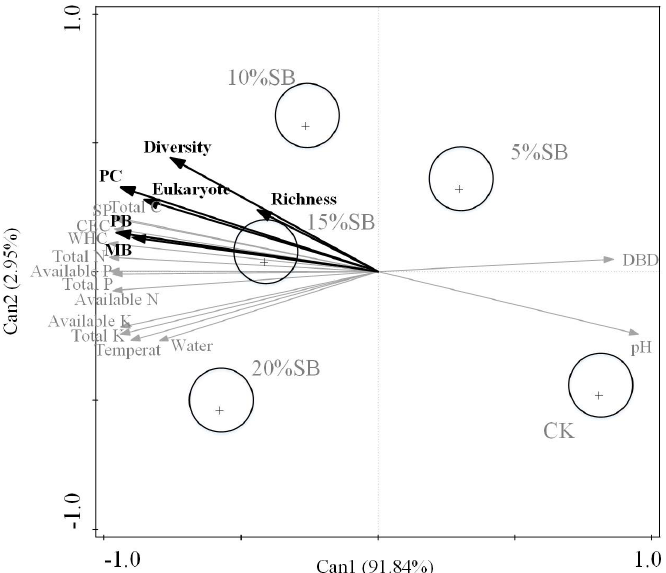
Figure 3. Generalized canonical discriminant and analysis (gCCA) showing the relationships among the soil physical properties, soil nutrients and abundance-based indicators of the green roof biology. Abundance-based indicators are the total microbial abundance, Shannon’s diversity index, Margalef’s richness index, total plants and eukaryotes. The circles represent the 95% confidence intervals around the site treatment mean. Abbreviations are expressed: DBD = dry bulk density, WHC = water-holding capacity, SP = soil porosity, Total C = total carbon, Total N = total nitrogen, Total P = total phosphorus, Total K = total potassium, Available N = available nitrogen, Available P = available phosphorus, Available K = available potassium, CEC = cation exchange capacity, PB = plant biomass, PC = plant carbon and MB = microbial biomass. Biochar addition treatments were: CK, no biochar; 5%SB, 5% biochar; 10%SB, 10% biochar; 15%SB, 15% biochar and 20%SB, 20% biochar.